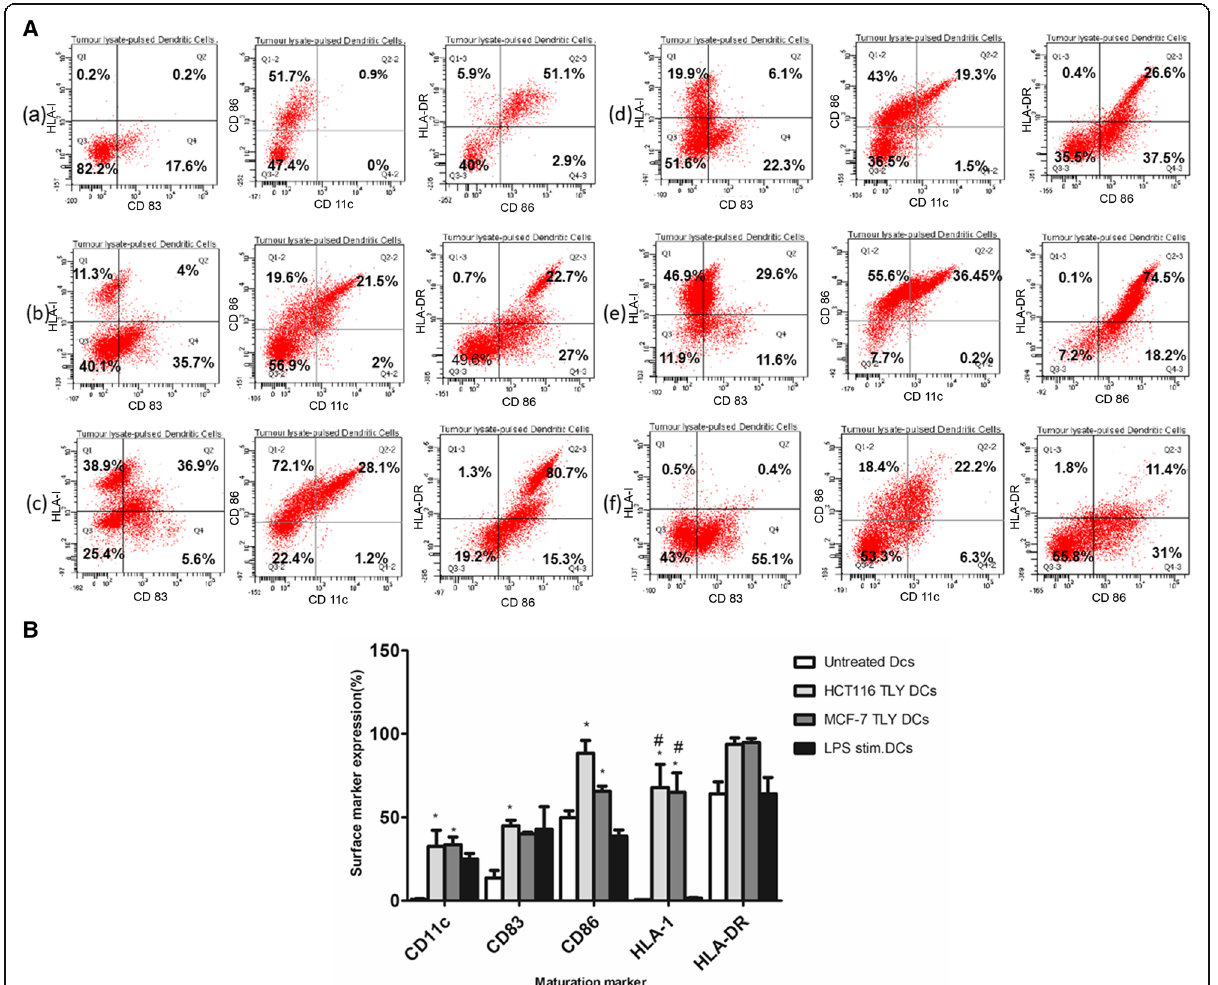
Fig. 4 Upregulation in the phenotypic expression of maturation markers in tumor lysate-pulsed dendritic cells. a Flow cytometric analysis of phenotypic HLA-DR, HLA-I, CD 83, 86 and CD 11c expression in (a) unloaded immature DCs, HCT-116-TLY-DCs at (b) 1:1, (c) 1:3 ratios, MCF-7-TLY at (d) 1:1, (e) 1:3 ratios, and (f) LPS-stimulated-only DCs. b The statistically transformed data show the significant increase in the expression levels of the maturation markers HLA-I, CD 83, 86 and CD 11c in tumor lysate pulsed dendritic cells over immature non-pulsed DCs (* P < 0.05) and LPS-only stimulated DCs (# P < 0.05). The data are representative of three experiments comprising three different healthy donors and analyzed by one-way ANOVA followed by Dunnett ’ s test. iDCs, immature dendritic cells; TLY, tumor lysate; LPS,